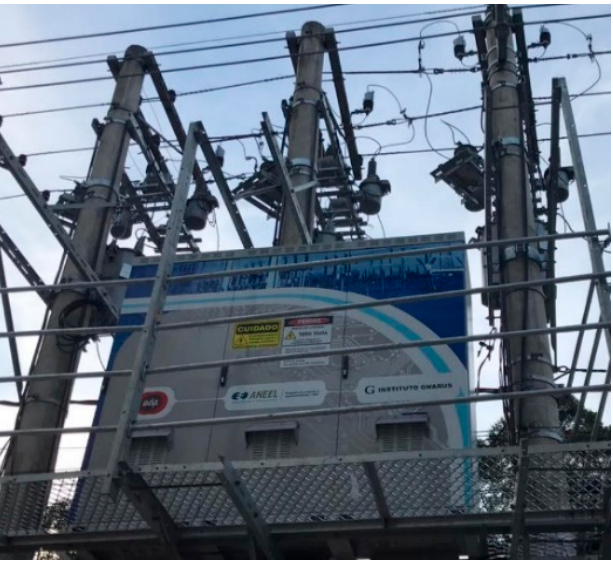
Figure 10. Developed three-phase series converter in outdoor installation—13.8 kV field test.